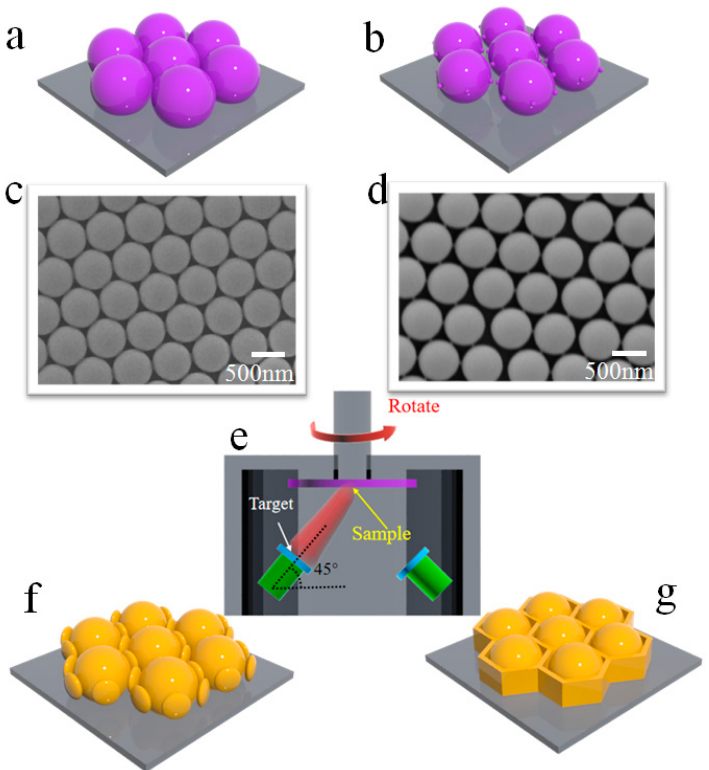
Figure 1. ( a , b ) Schematic diagram of hexagonally arranged polystyrene (PS) colloid sphere array and PS colloid sphere array with six tiny synaptic nanostructures after reactive ion etching (RIE) treatment, respectively. ( c , d ) SEM image of hexagonally arranged PS colloid sphere array before and after RIE treatment. ( e ) Schematic diagram of the magnetron sputtering chamber. ( f , g ) Desired honeycomb nanostructure achieved by controlling rotational speed and film sputtering time. Reproduced with permission from [38] American Chemical Society,